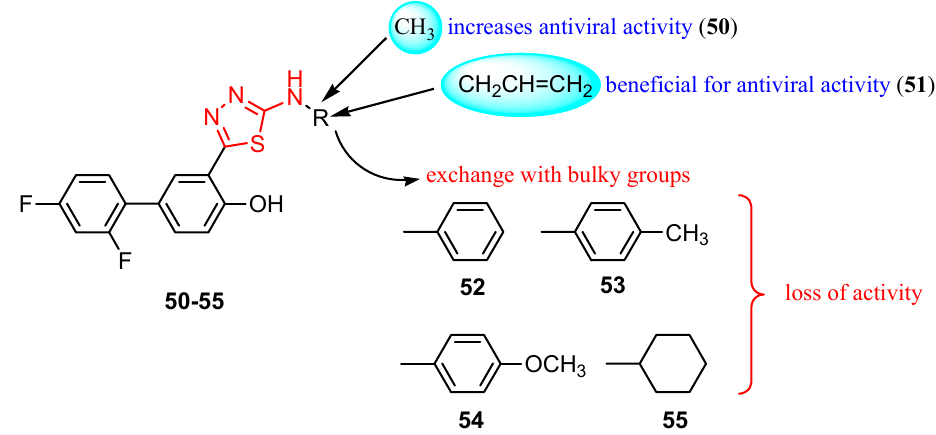
Figure 6. The influence of substituents of 1,3,4-thiadiazole derivatives 50 – 55 on viral inhibition. 2-Phenylamino-1,3,4-thiadiazole derivatives 45 – 48 were also screened against herpes simplex HSV-1 and HSV-2, herpes simplex virus-1 TK-KOS ACV, Sindbis virus, Coxsackie virus B4 and